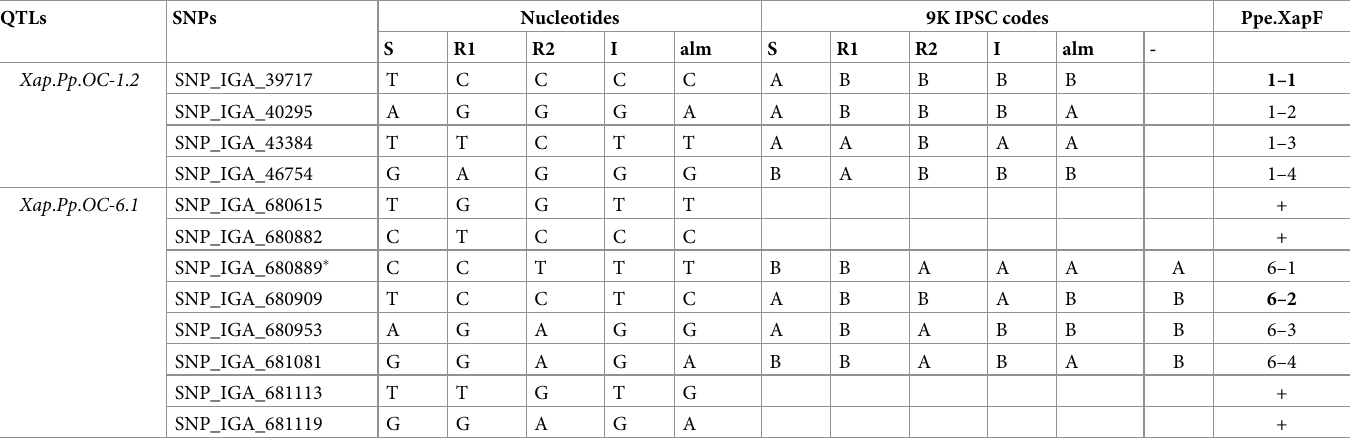
of each forward primer and 45 μ L of the reverse primer were combined with 69 μ L of 10 mM Tris-HCl, pH 8.0. The reaction mixture for each assay included 432 μ L of 2 × PACE ™ 2.0 geno- typing master mix with no ROX (3CR Bioscience, Harlow, Essex, UK) (which includes poly- merase, dNTPs, buffer, and HEX- and FAM-tagged oligonucleotides) and 11.88 μ L of the appropriate primer master mix. Genotyping assays used 5 μ L of reaction mixture and either 5 μ L of water (no-template control) or 5 μ L of genomic DNA at approximately 5 ng/ μ L. Three replicates of no-template controls and positive controls for AA, AB, and BB genotypes for the tested SNPs were always included, along with unreplicated samples of unknown genotype (“unknowns”). Positive controls were chosen from 18 accessions previously genotyped with the peach 9K SNP array [17] as part of the Peach Crop Reference Set [28] within the Ros- BREED project (www.rosbreed.org) (Table 2). A total of 3,440 seedlings were organized in ~40 96-well plates using the OT-2 robot, with all control samples in row A at the 2.5 ng/ μ L DNA concentration (S2 Table). As control sample DNA was of a high quality, we reduced its con- centration from the recommended 5 to 2.5 ng/ μ L to adjust fluorescence levels between con- trols and the crude DNA. Reactions were performed in a Bio-Rad CFX Connect Real-Time PCR Detection System using the following program for all SNPs except Ppe.XapF1-3 and F6-2: 15 min at 95˚C (acti- vation), followed by 10 touchdown cycles of 94˚C for 20s (denaturing), 61-55˚C for 60s (drop- ping 0.6˚C per cycle, for annealing and elongation), followed by 40 cycles of 94˚C for 20 s, 55˚C for 60s, 23˚C for 30s (for accurate plate reading). The Ppe.XapF1-3 and Ppe.XapF6-2 required higher temperatures for annealing/elongation (58˚C for XapF1-3, 57˚C for XapF6-2) to generate clearly separated genotype clusters, and consequently used a smaller temperature decrement during the 10 touchdown PCR cycles. For each plate, the cycle used for genotype assignment was chosen to maximize separation between genotype clusters and minimize back- ground amplification, usually between cycles 22–28 of the 40-cycle period. Endpoint PCR reactions, omitting the step of 23˚C for 30s and plate reading, were performed on Bio-Rad from real-time PCR. High-quality DNA from previously genotyped samples was used first